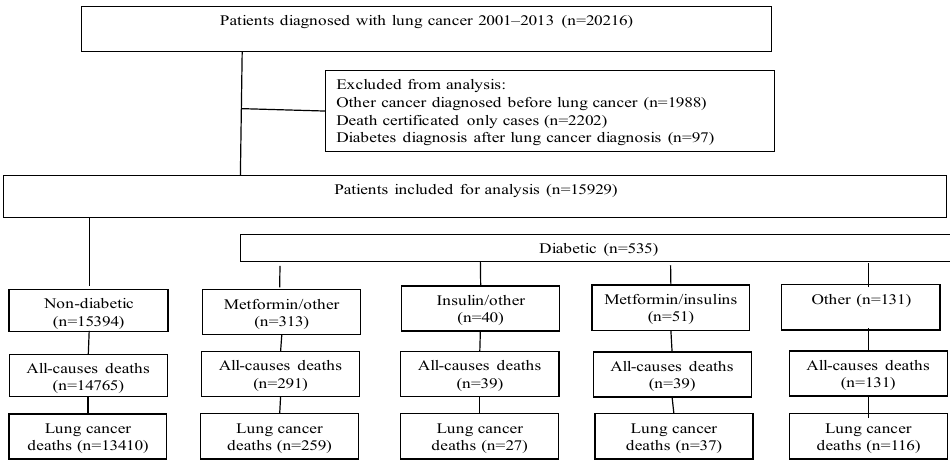
Figure 1. Study flow chart of lung cancer patients.